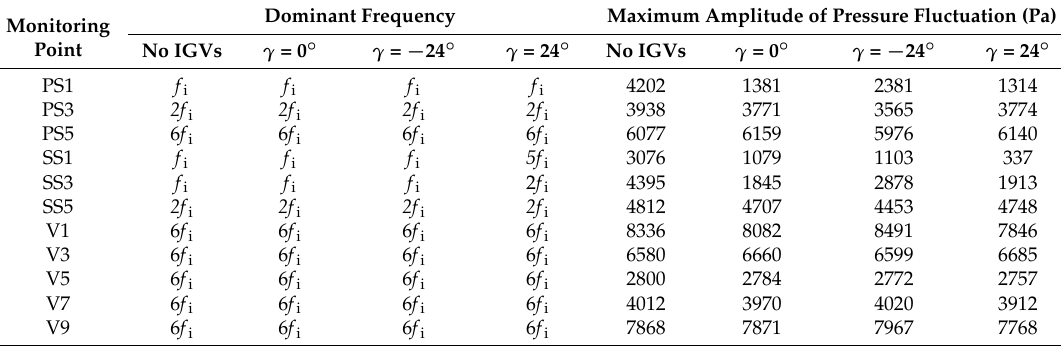
Table 4. Spectrum analysis of pressure fluctuations in pumps without and with IGVs ( Q = 340 m 3 /h).